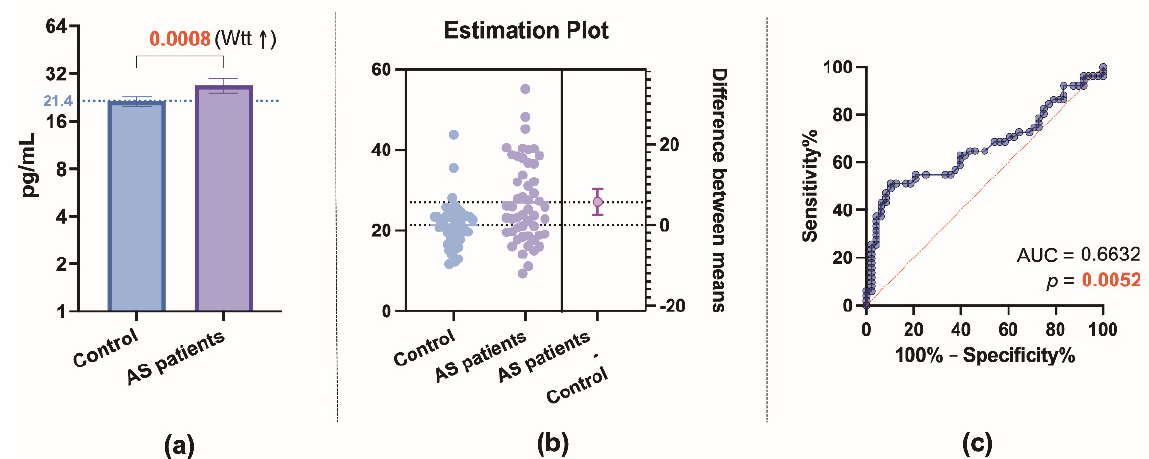
Figure 2. Plasma thioredoxin-1 (TRX1): ( a ) comparison of TRX1 concentration in control subjects and aortic valve stenosis (AS) patients. Wtt—Welch t test; ( b ) estimation plot displaying the raw data and the 95% confidence interval for the difference between means; ( c ) receiver-operating characteristic curve for TRX1 as a diagnostic marker of AS (control group vs. AS patient group). AUC—the area under the curve.